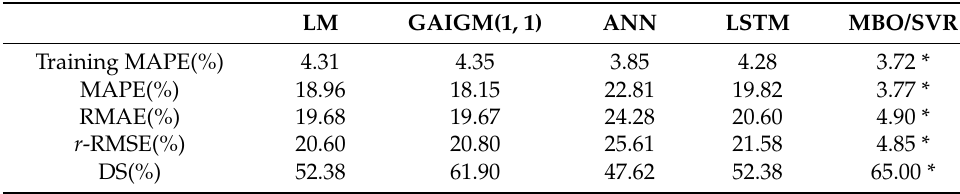
Table 6. Comparison of the models’ performances.